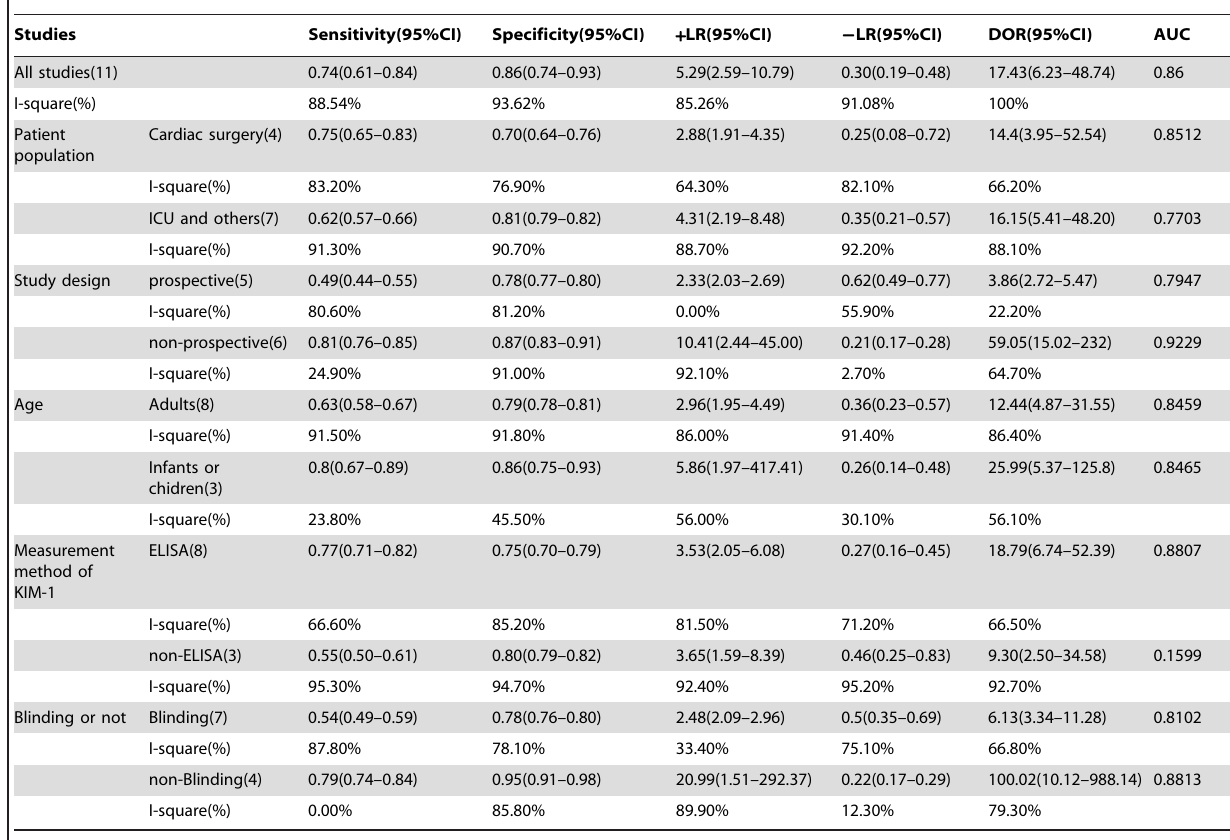
Table 3. Subgroup analysis based on different standard.